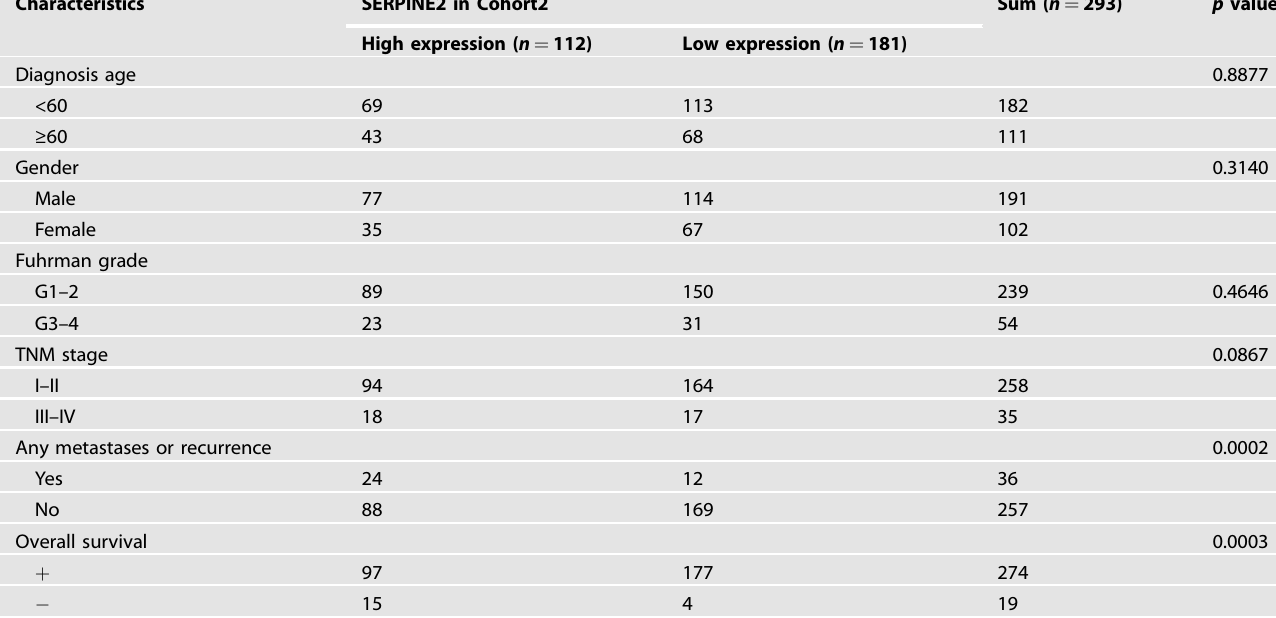
Table 2. Clinical characteristics of patients according to SERPINE2 expression a in Cohort2 ( n = 293).